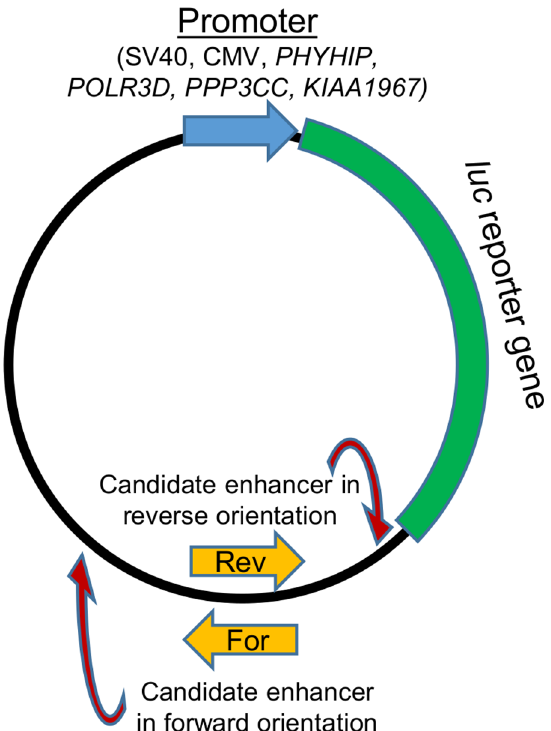
Fig 3. Structure of luciferase reporter vectors used in the assays. pGL4.10 plasmid was used to construct vectors with luc gene expression driven by various promoters (upper part in brackets) and a candidate enhancer in either orientation (lower part). Because the candidate enhancers also possess promoter activity, to discern between those, the vectors were linearized by cutting at the sites shown with red arrows. Note that after such linearization the candidate enhancer will be located either upstream (reverse orientation) or downstream (forward orientation) of the luc gene and its